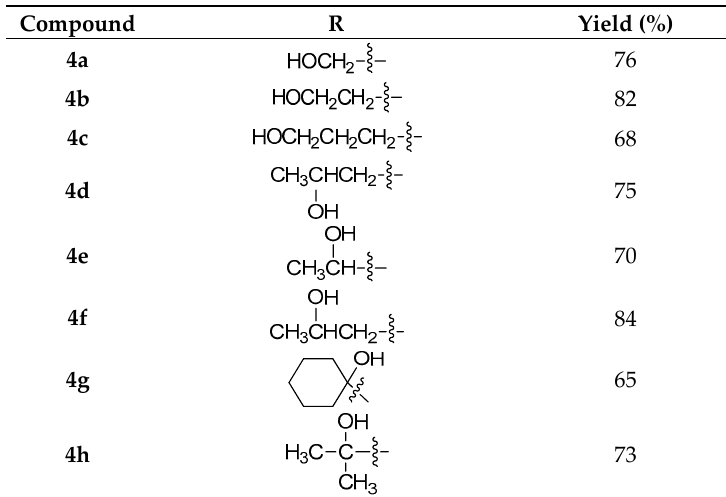
Scheme 1. Synthesis of novel 1,2,3-triazole derivatives 4a  4h . Glycerol was utilized as starting Scheme 2. Synthesis of novel 1,2,3-triazole derivatives 4a – 4h . Glycerol was utilized as starting material